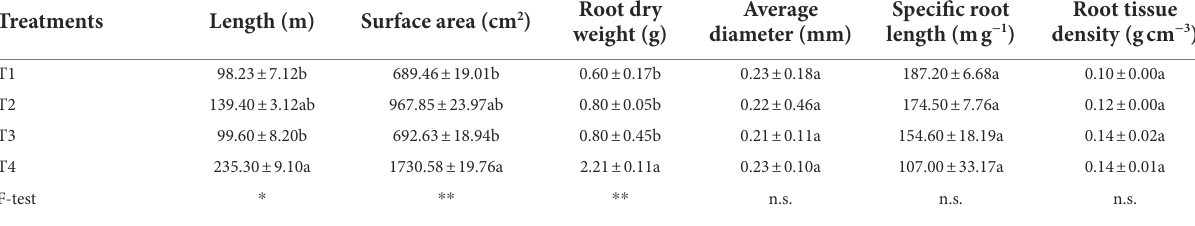
TABLE 2 Belowground plant performance parameters of Cannabis sativa KKU05 grown under different conditions at 60 DAT.